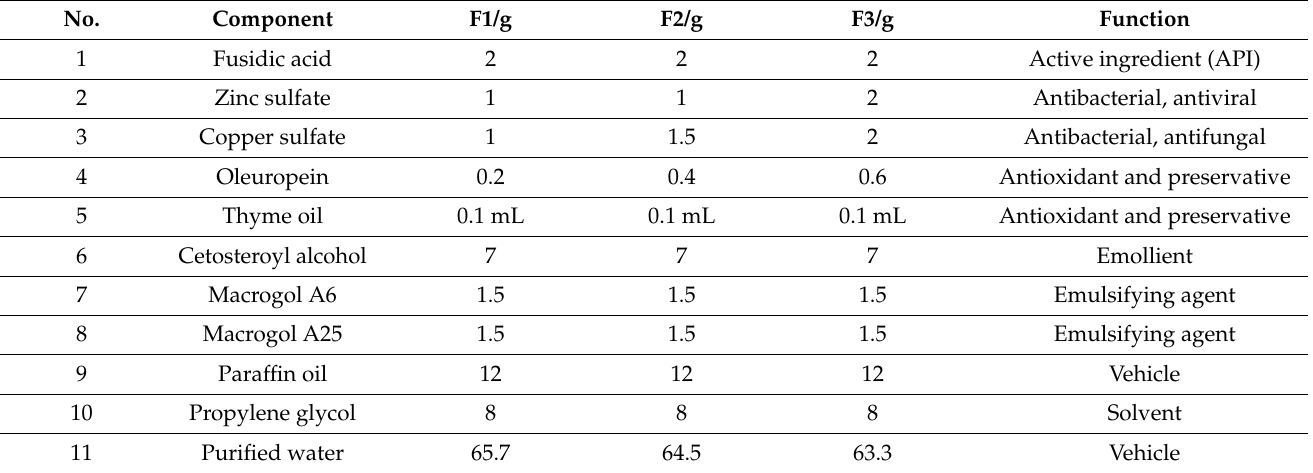
Table 1. Qualitative and quantitative compositions of 3 fusidic acid cream